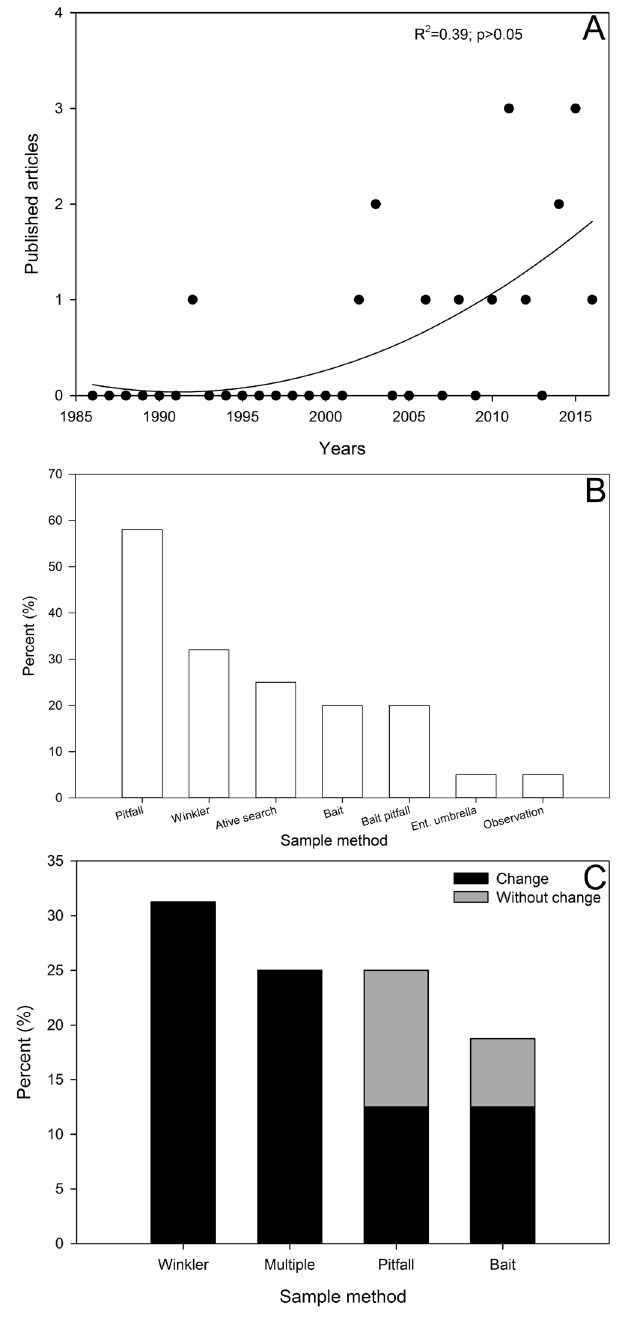
Fig 1 . (A) Papers analyzed using ants as bioindicators in the Brazilian Savanna in relation to publication years; (B) Collection methodologies used in the studies analyzed.The papers presenting two or more methods were computed separately, adding up to 100%; (C) Percentage of papers with or without change in richness and composition of species in relation to the sampling